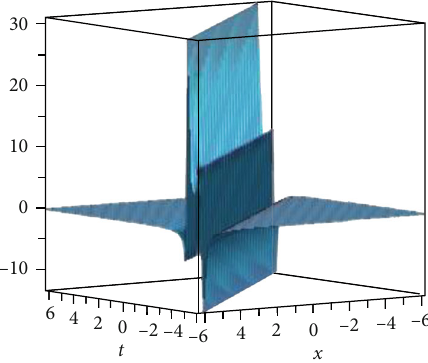
ð z Þ for the fi xed values v = 1 , z s ,1